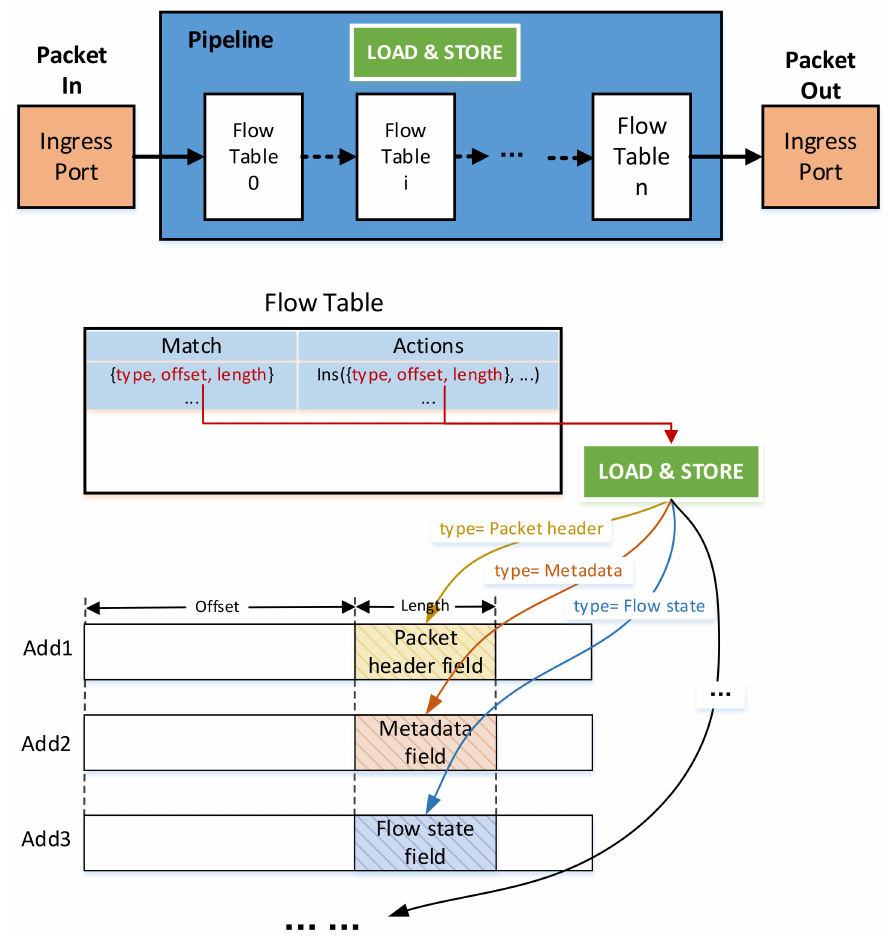
Figure 3. The Load and Store module is used to load and save data in the Match-action